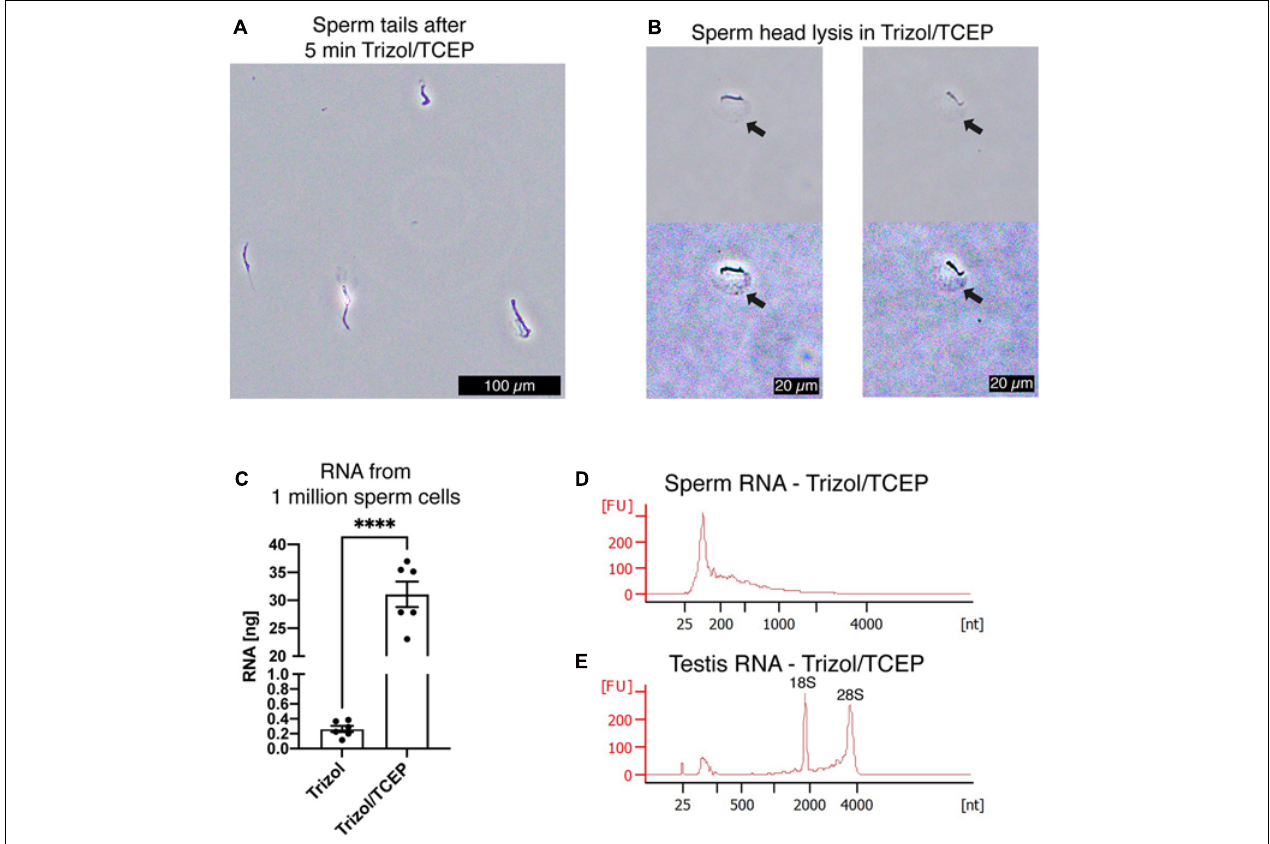
FIGURE 5 | TCEP enhances AGPC lysis and increases sperm RNA yield. (A) Mouse sperm cells are rapidly lysed in Trizol supplemented with 50 mM TCEP. Only clumped sperm tails remain visible indicating complete lysis of sperm heads. Scale bar = 100 µ m. (B) Details of mouse sperm lysis in Trizol/TCEP. In comparison to lysis of mouse sperm in Buffer RLT+/ β ME, the acrosome remains visible for longer and a distinct swelling of the nucleus containing sperm head is observed (black arrows). In the second row, color contrast of microscopy pictures was increased to highlight the swelling. Scale bars = 20 µ m. (C) Comparison between RNA yield in ng from 1 millions sperm cells when extracted with only Trizol or Trizol supplemented with TCEP. Trizol/TCEP extraction increased the RNA yield to an average of 30 ng ( n = 6 per lysis condition). (D,E) Bioanalyzer electropherograms of RNA concentration in fluorescence units (FU) for a given nucleotide length (nt). (D) Sperm RNAs extracted from Trizol/TCEP were comprised mostly of RNAs shorter than 200 nt. (E) Testis RNA extracted from Trizol/TCEP was comprised of longer RNAs with distinct peaks at 1,800 and 3,800 nt. Data are represented as mean ± standard error of mean (SEM). **** p <